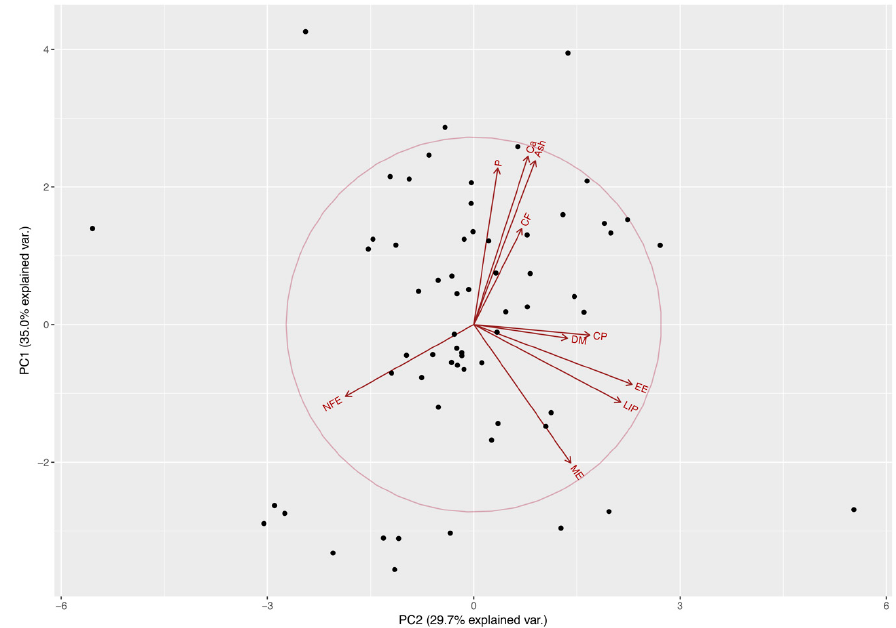
Figure 1. Distribution of food preference of kennel cats, on the first two principal components extracted from estimate contents of dry matter (DM), crude protein (CP), crude fiber (CF), ether extract (EE), nitrogen free extract (NFE), ash, calcium (Ca), phosphorus (P), total lipids (LIP) and metabolizable energy (ME) by proximal chemical analysis, acid hydrolysis, and calorimetric pump food decomposition. Space distribution of diet variables according to components 1 and 2, plotted as their eigenvectors.